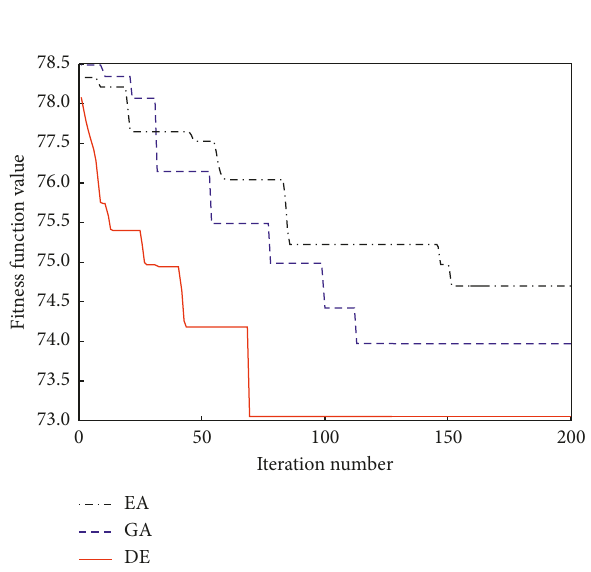
Figure 17: Searching procedure